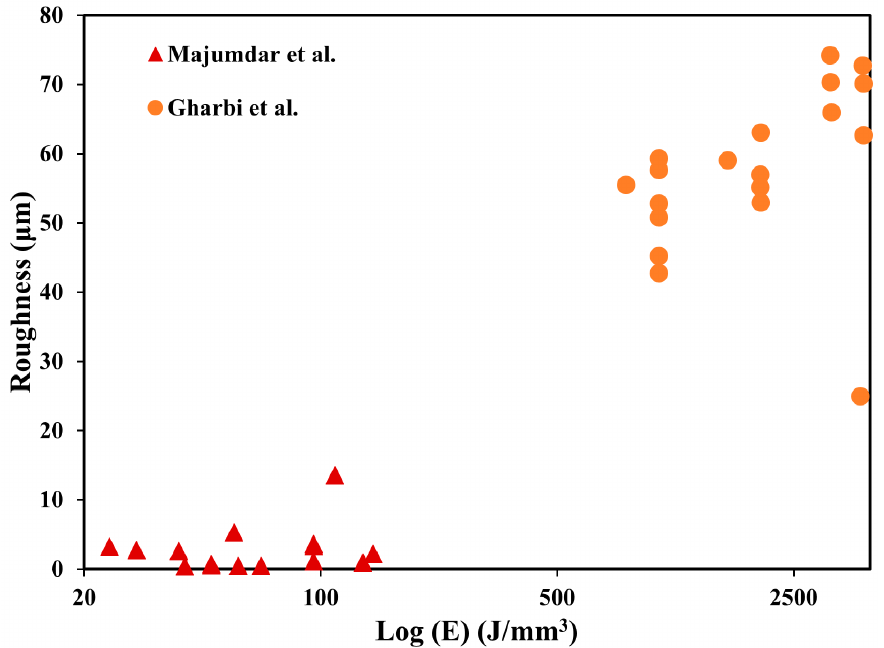
Figure 3. The relationship between energy density and average roughness ( R a ) for Ti-6Al-4V in DMD systems.